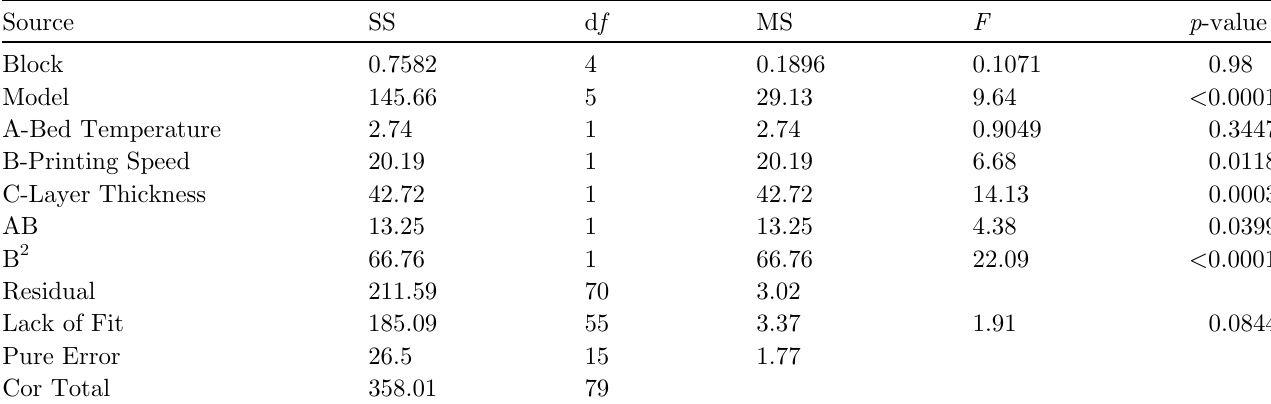
Table 4. ANOVA of bottom surface